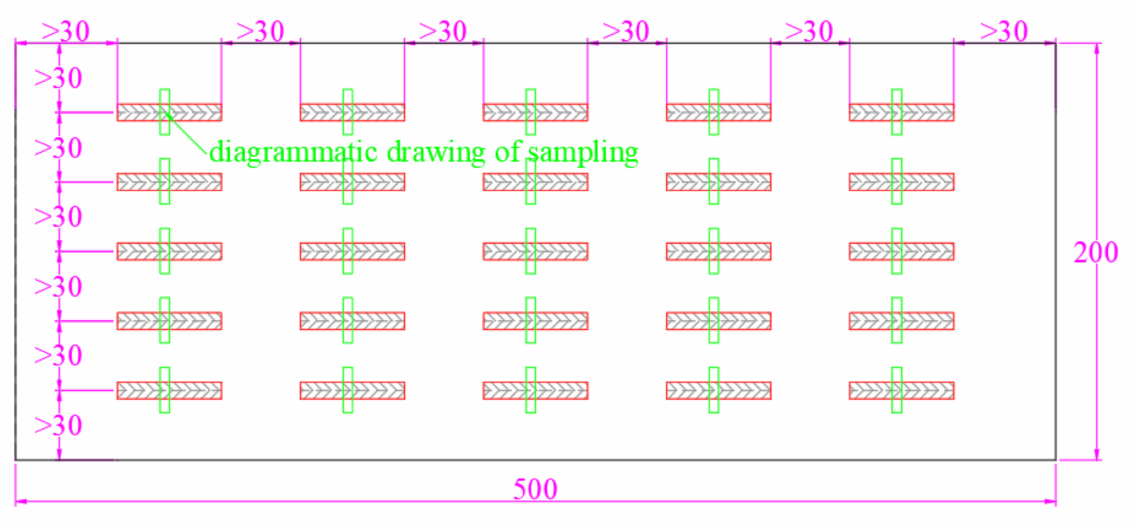
Figure 4. Layout of the beads and place of